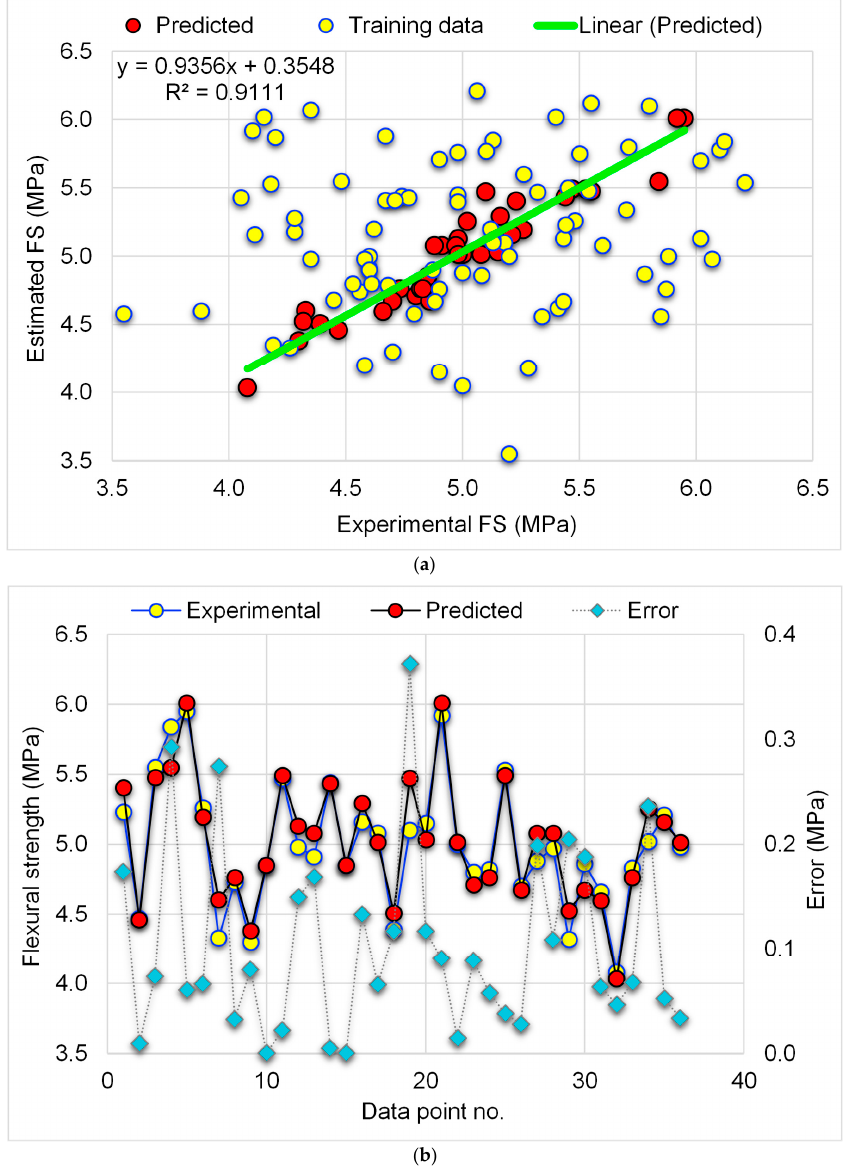
Figure 10. RFR-FS model: ( a ) correlation amongst experimental and predicted FS; ( b ) distribution of experimental and predicted FS and error values.